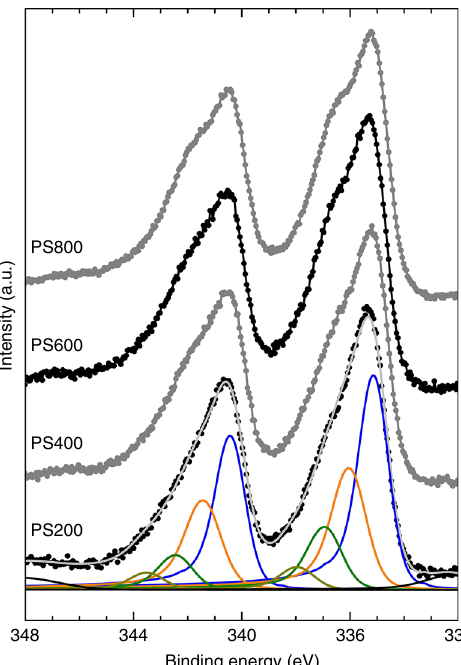
hydrogen chemisorption (ratio of reversibly to irreversibly chemisorbed